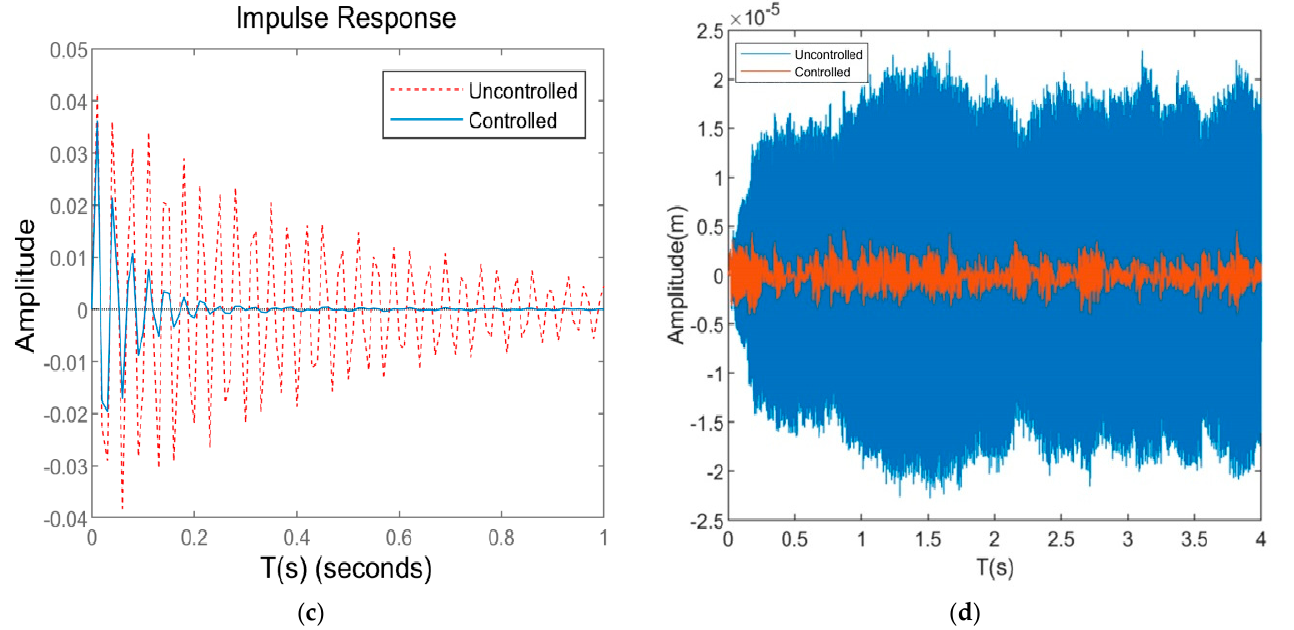
Figure 13. Response diagram before and after system control. ( a ) Response of CFFF plate under pulse excitation; ( b ) CFFF plate response under white noise; ( c ) response of CFCF plate under pulse excitation; ( d ) CFCF plate response under white noise.